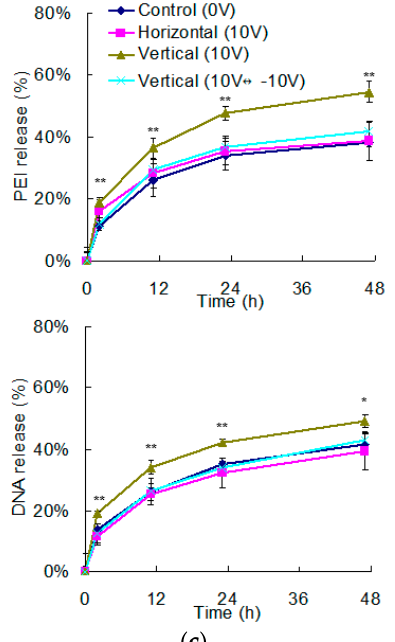
Figure 2. The effects of electrical field modes on polyelectrolyte delivery from PEMs. ( a ) Schemes of three different modes of electrical field. ( b ) The releases of PEI and DNA during 1 h treatment of different electrical fields. ( c ) PEMs with 1 h treatment of electrical fields were monitored for their following delivery in aqueous environments for 48 h (n = 3; t -test compared to the results of the control group at the same time, * p < 0.05; ** p < 0.01).